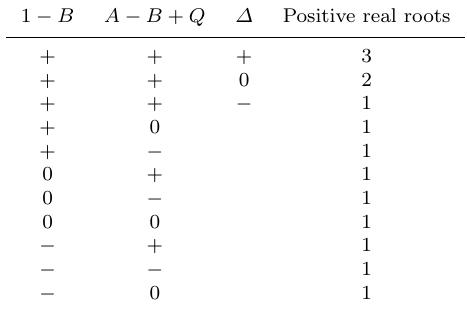
Table 1. Number of positive real roots of Equation